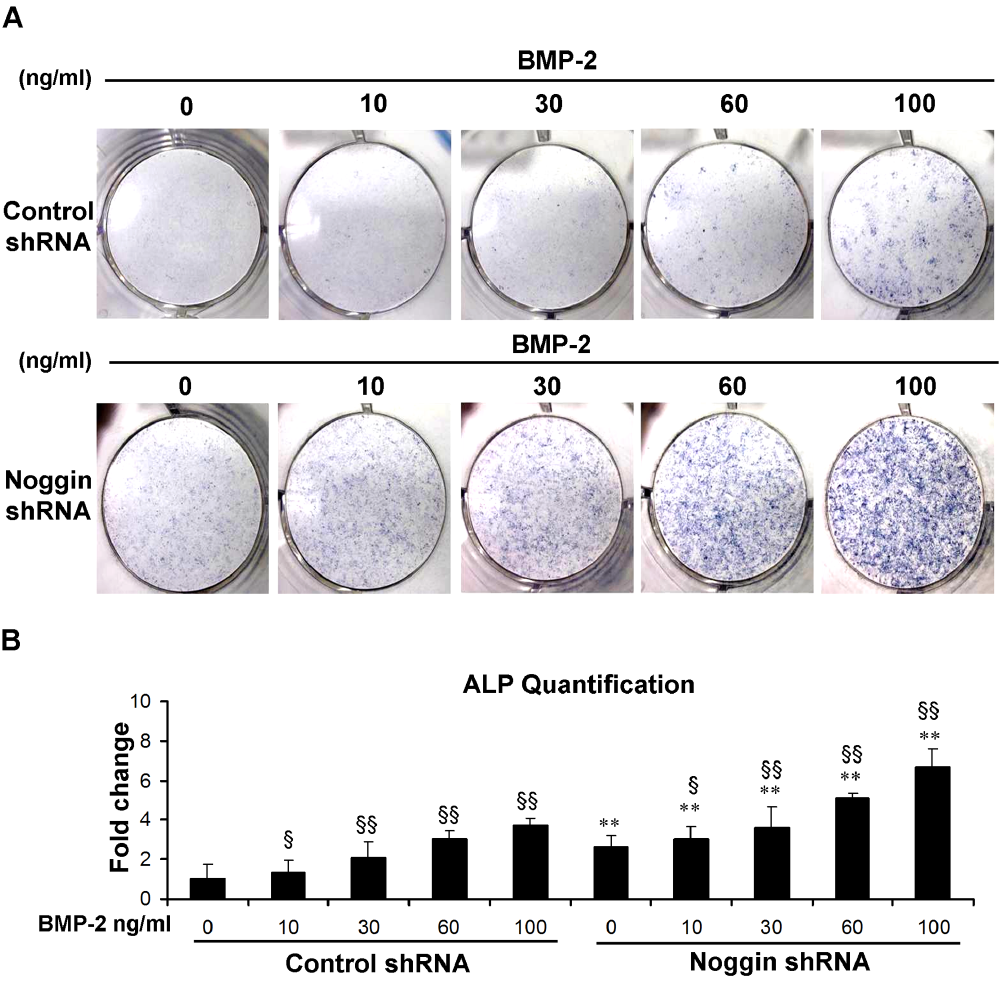
Figure 2. Alkaline phosphatase (ALP) expression of ASCs in monolayer culture. ALP was increased in ASCs transduced with noggin shRNA in the presence or absence of BMP-2 as assessed by ALP staining (A) and quantification (B) at day 3. (** p , 0.01 compared to their corresponding controls transduced with control shRNA). Significantly more staining was observed after treatment with different doses of BMP-2 ( 1 p , 0.05, 11 p , 0.01).